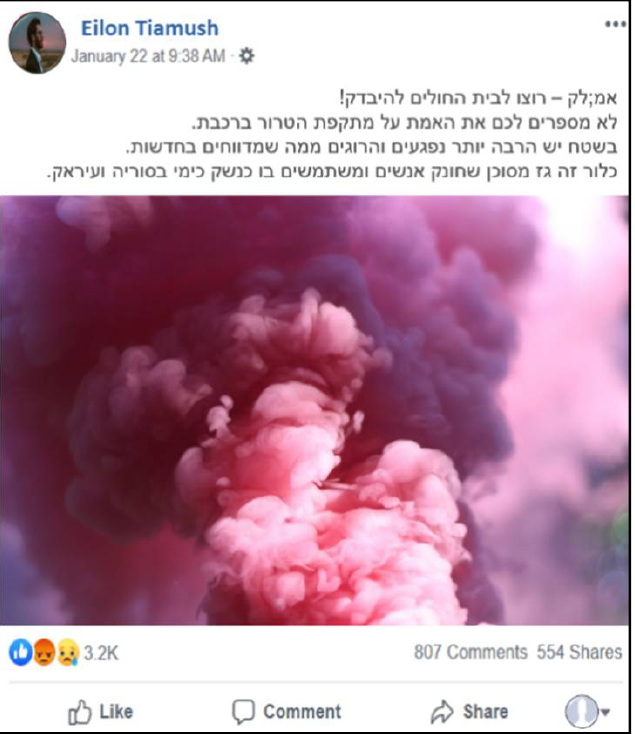
Figure A2. Screenshot of the mock social media news report for the chemical scenario.